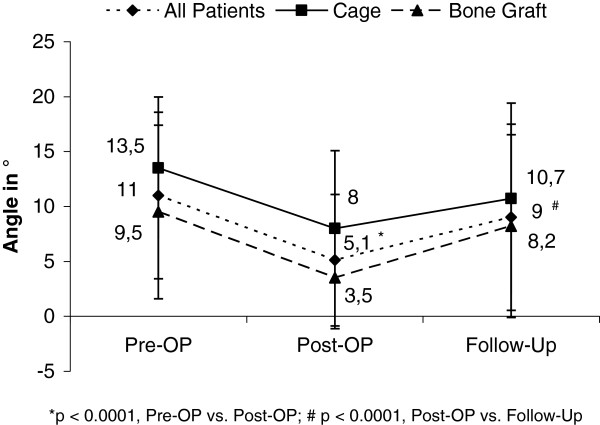
Superior-Inferior Endplate Angle (SIEA) measured preoperatively, immediately postoperatively and at follow up.